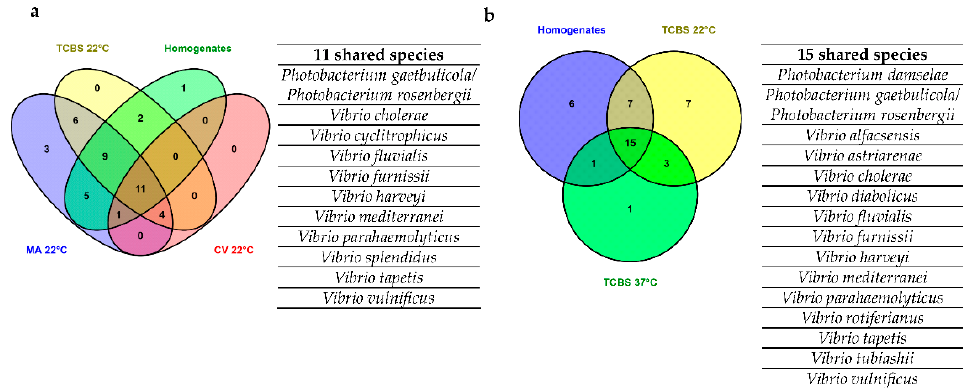
Figure 4. Venn diagram showing the number of Vibrio and Vibrionaceae species, identified by rec A- pyr H metabarcoding, shared among homogenate and clam samples plated on MA 22 ◦ C, TCBS 22 ◦ C and CV 22 ◦ C media ( a ) and among homogenate and clam samples plated on TCBS 22 ◦ C and TCBS 37 ◦ C media ( b ). The two tables report the details of the number and names of shared species among homogenate and plated clam samples. MA 22 ◦ C: clam samples plated on marine agar and incubated at 22 ◦ C; TCBS 22 ◦ C: clam samples plated on thiosulfate-citrate-bile salts-sucrose agar and incubated at 22 ◦ C; CV 22 ◦ C: clam samples plated on CHROMagar Vibrio media and incubated at 22 ◦ C.